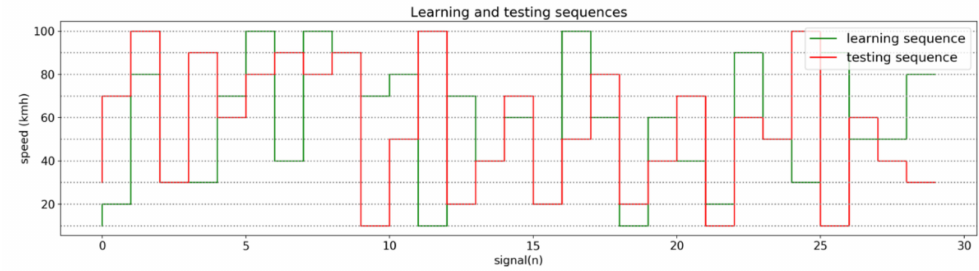
Figure 2. Learning and testing